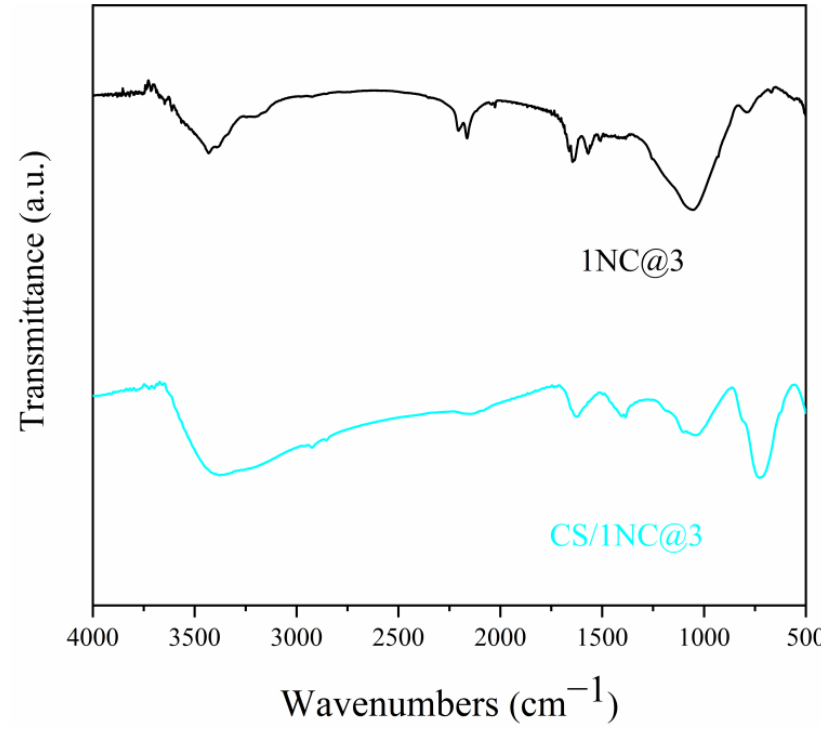
Figure 6. FTIR spectra of the CS/1NC@3 and NC@3.